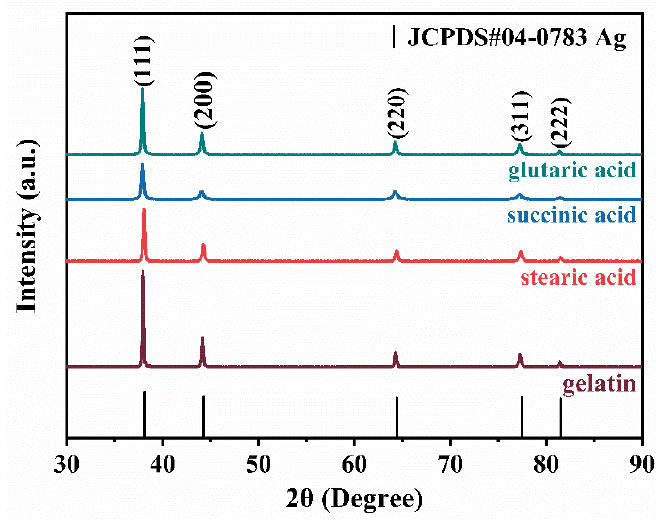
Figure 3. XRD of silver powder prepared with different dispersants.